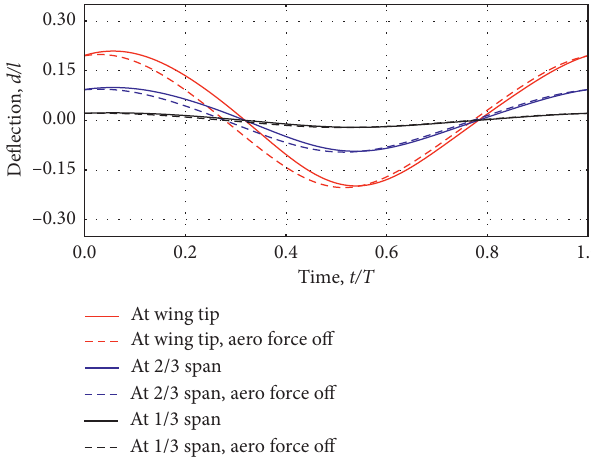
Figure 11: The deflections at the leading-edge points of the 1/3 span, 2/3 span, and